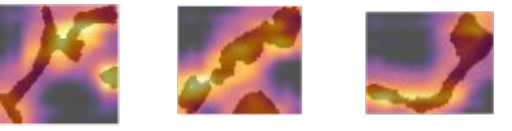
Figure 5. Type III nodule-significant shapes colorized by Grad-CAM.